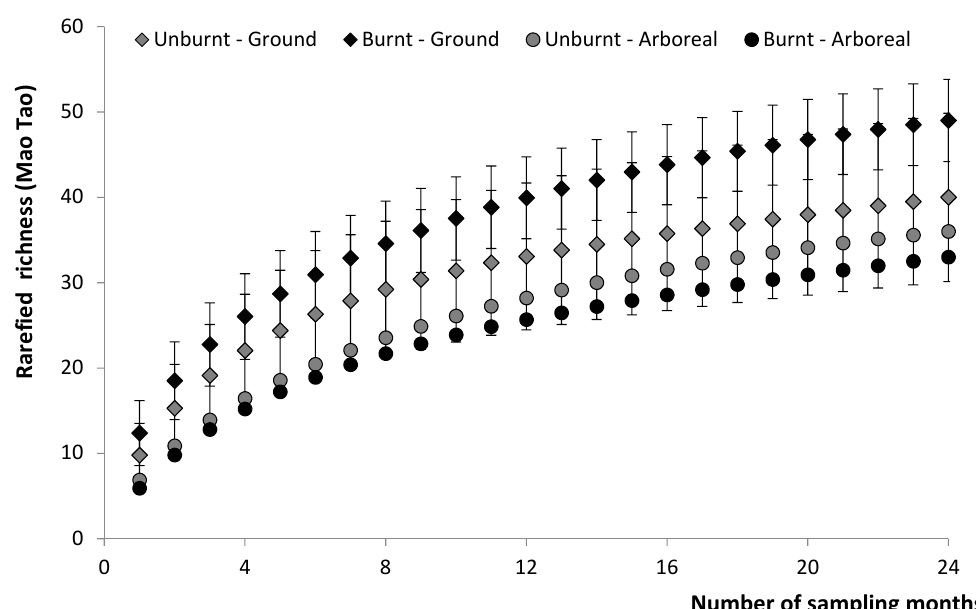
Figure 1. Rarefaction curves (with confidence intervals—95%) for ant species collected in the burnt area (dark symbol) and unburnt area (gray symbol). Ground ant species are represented by diamonds and arboreal ant species are represented by spheres.